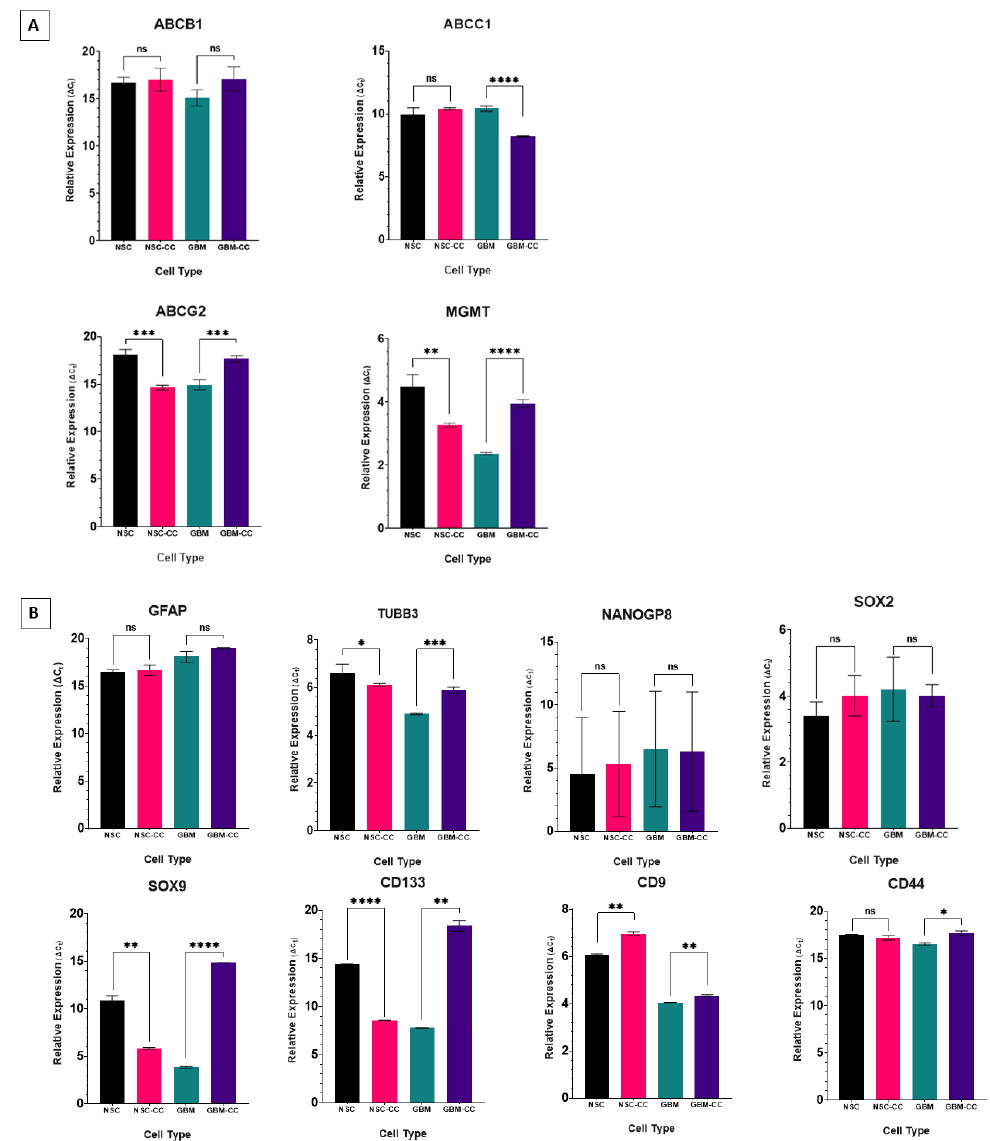
Figure 2. Relative expression graphs for GBM and NSC cocultured cells. ( A ) ABC transporter cluster: ABCB1, ABCC1, ABCG2, and MGMT (DNA repair). ( B ) Stemness/CSC cluster: CD9, CD133, CD44, GFAP, TUBB3, NANOGP8, SOX2, and SOX9. NS: no statistically significant, *: p < 0.05, **: p < 0.01, ***: p < 0.005, ****: p < 0.001.